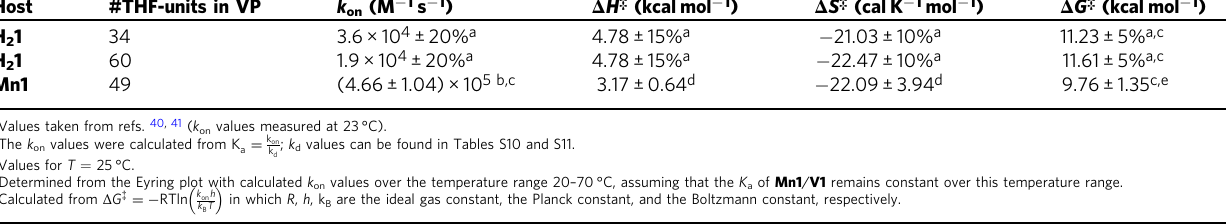
Table 3 k on values and threading parameters for Mn1/VP, and reference parameters for H 2 1 with comparable poly-THF substituted viologen guests.